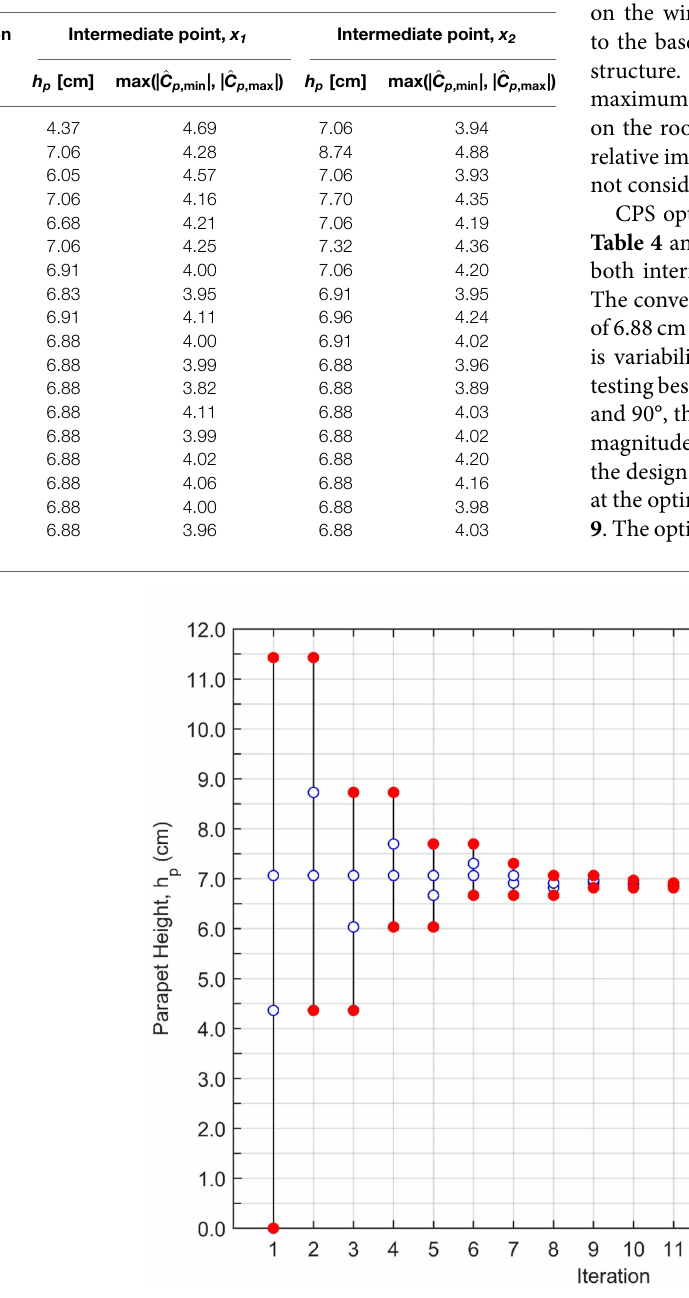
FIGURE 10 | Parapet height iteration history using golden section search (Case